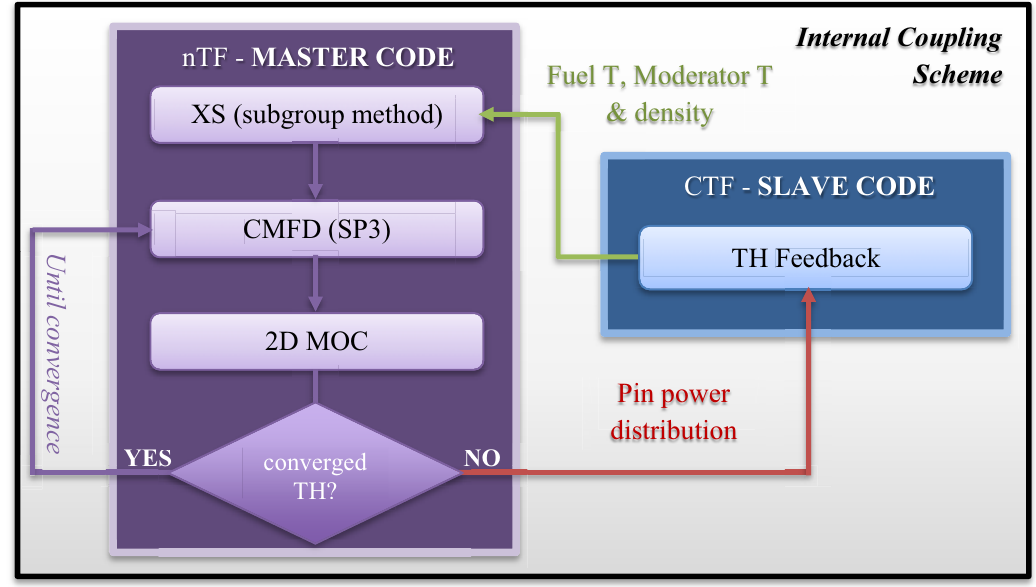
Figure 1. Internal coupling scheme for the high resolution multi-physics